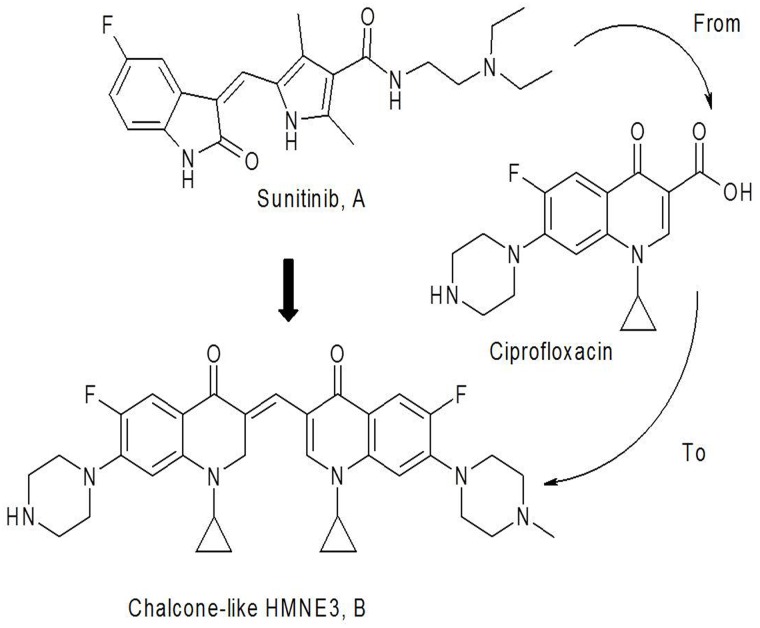
The structure and name of the bis-fluoroquinolone chalcone-like derivative HMNE3.(1-cyclopropyl-3-[1-cyclopropyl-6-fluoro-7-piperazin-1-yl-2,3-dihydro quinolin-4(1H)-one-3-ylidenemethyl]-6-fluoro-7-(4-methylpiperazin-1-yl)-quinolin-4 (1H)-one).